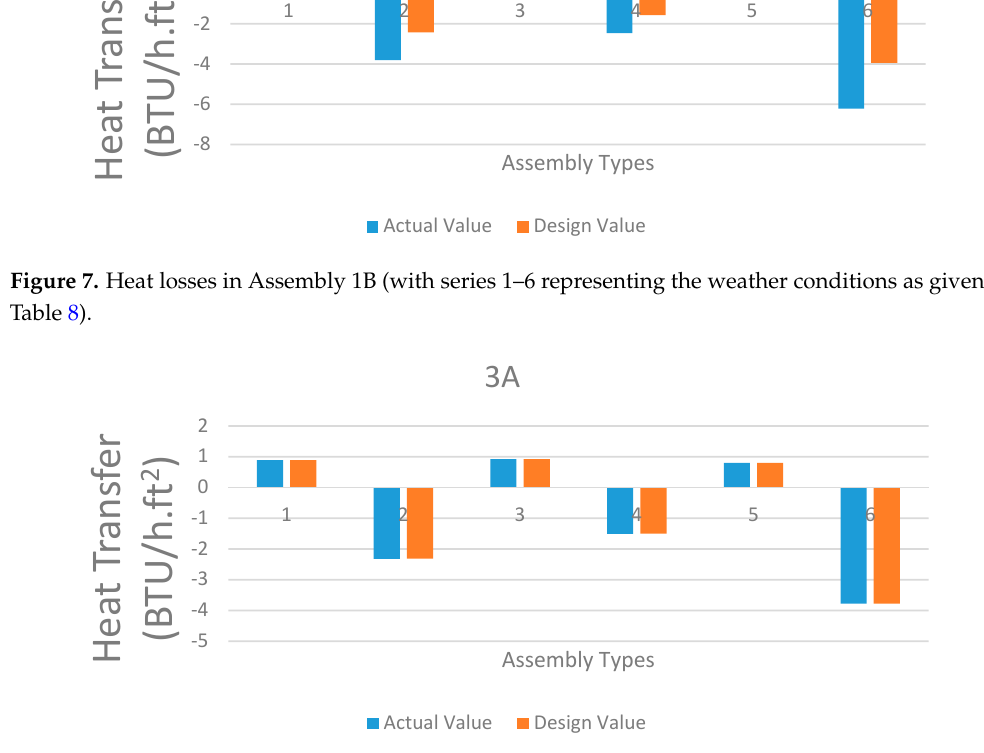
Figure 8. Heat losses in Assembly 3A (with series 1–6 representing the weather conditions as given in Table 8).